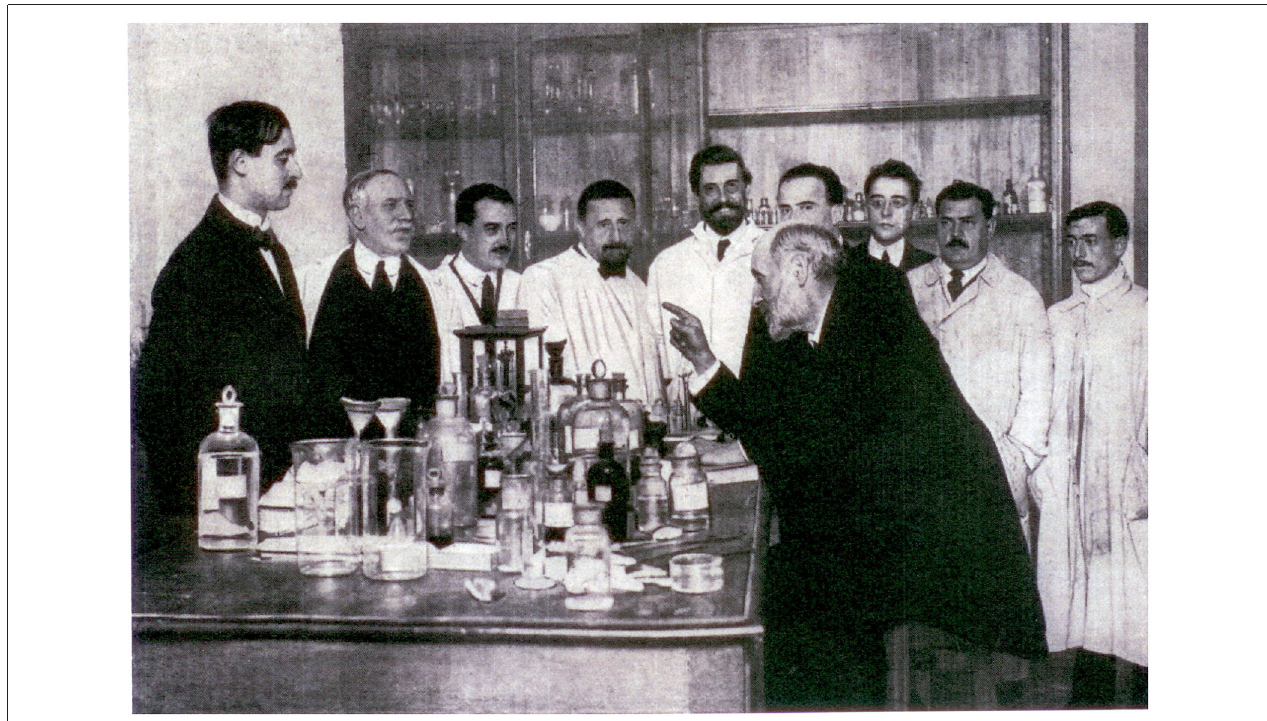
FIGURE 4 | Cajal with some of his disciples in his laboratory . First and second on the left: G. Lafora and D. Sánchez, respectively, in the middle N. Achúcarro (Courtesy of the Cajal Institute,